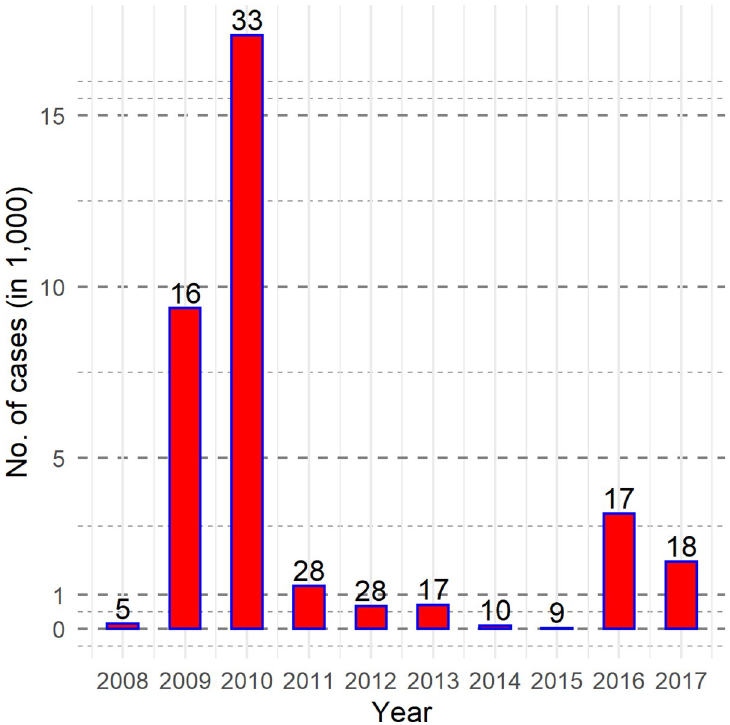
Fig 1. Distribution of cholera cases, by WHO case definition, by year, 2008–2017. Note: No. of cholera affected districts are recorded on the top of bars.